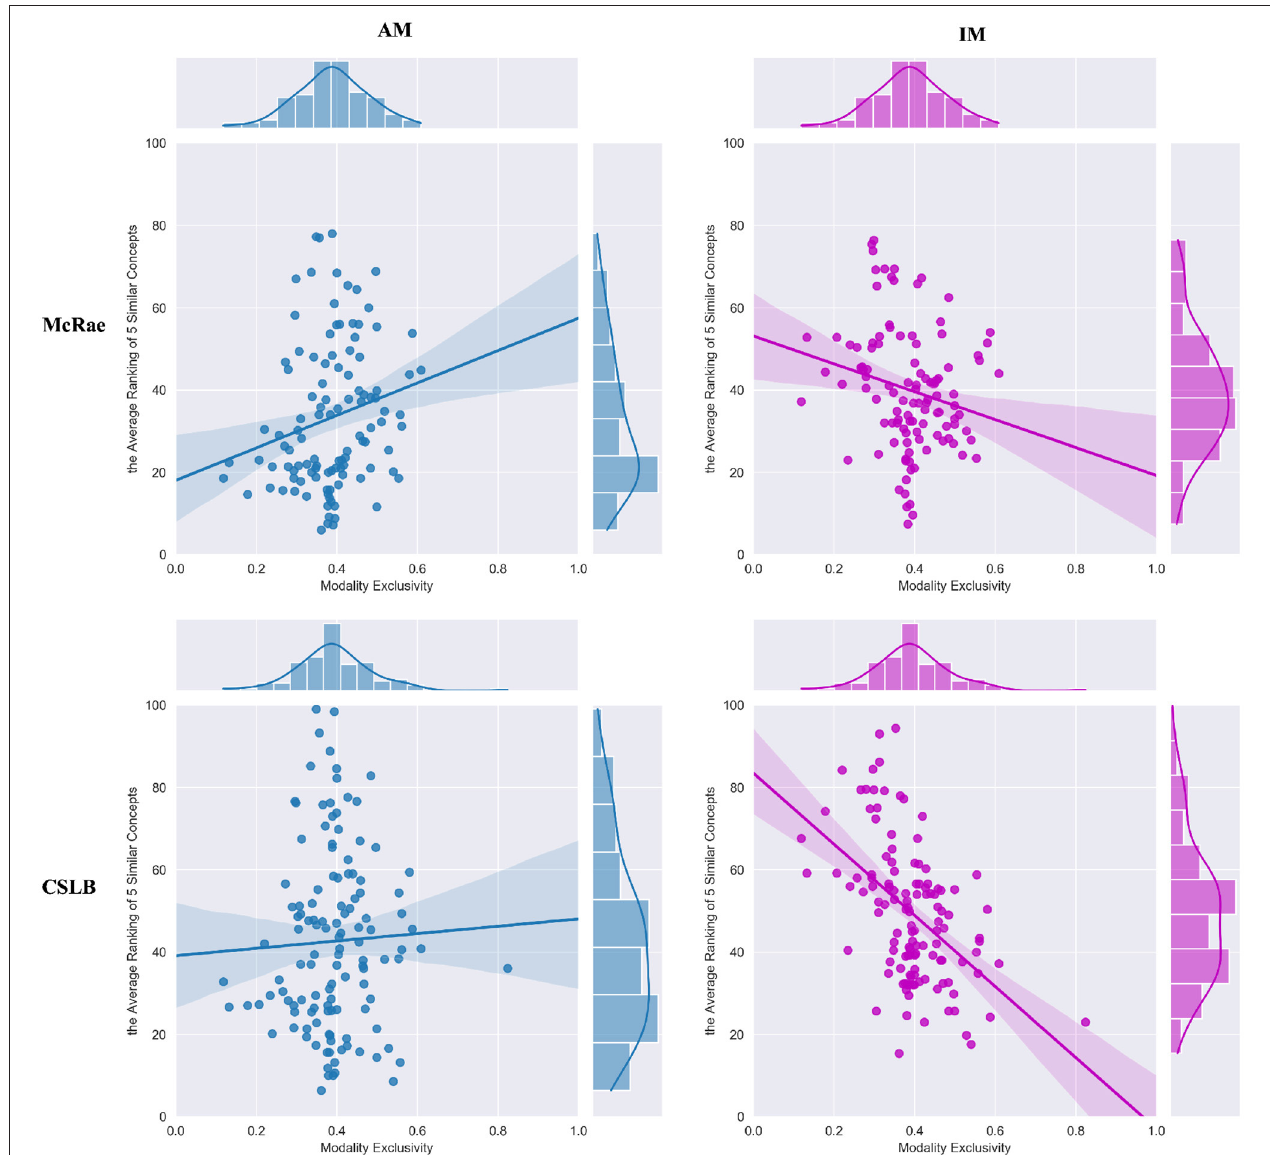
FIGURE 4 | The correlation between ME and average of five similar concept